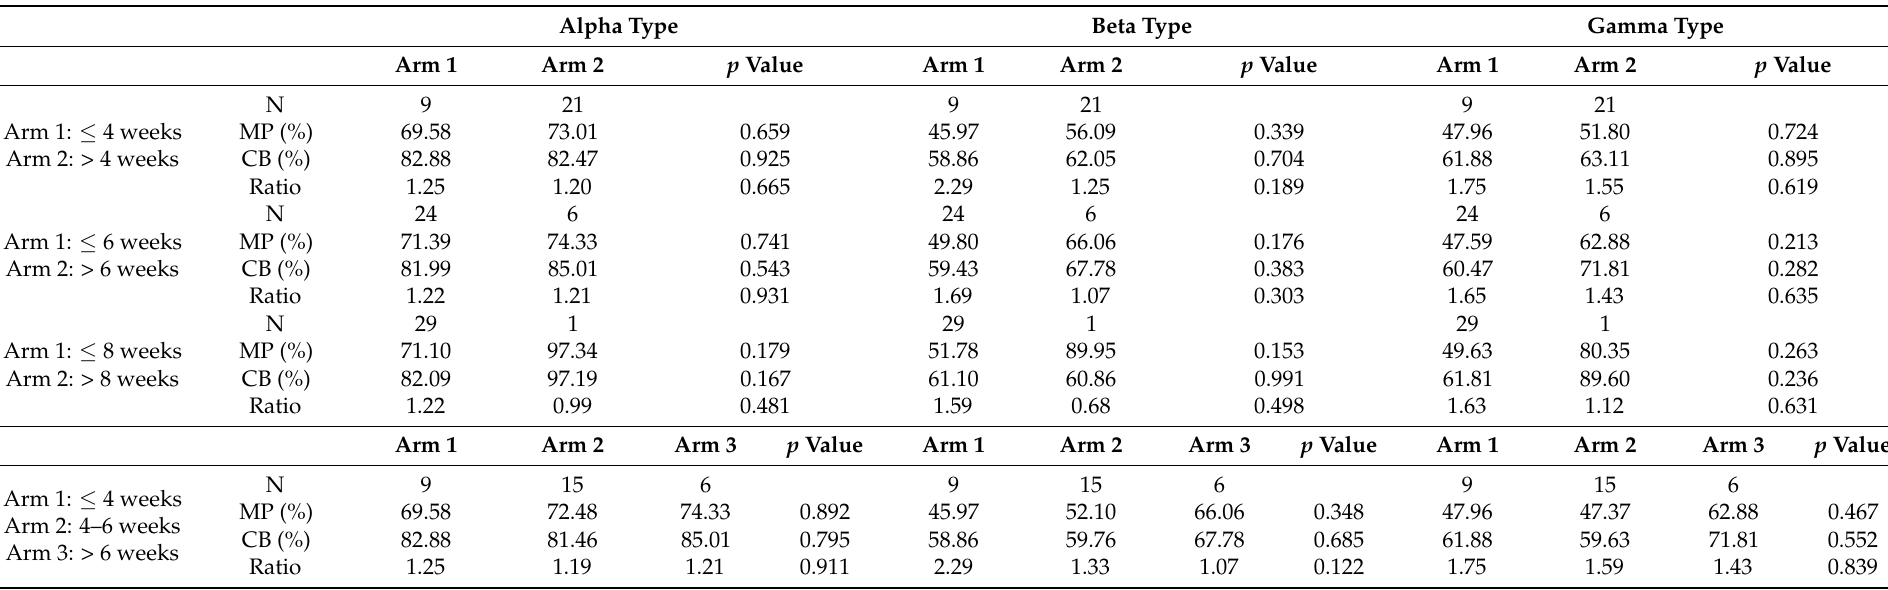
Table 2. SRBD IgG binding ratio for SARS-CoV-2 Alpha, Beta, and Gamma variants with different intervals between two COVID-19 vaccine